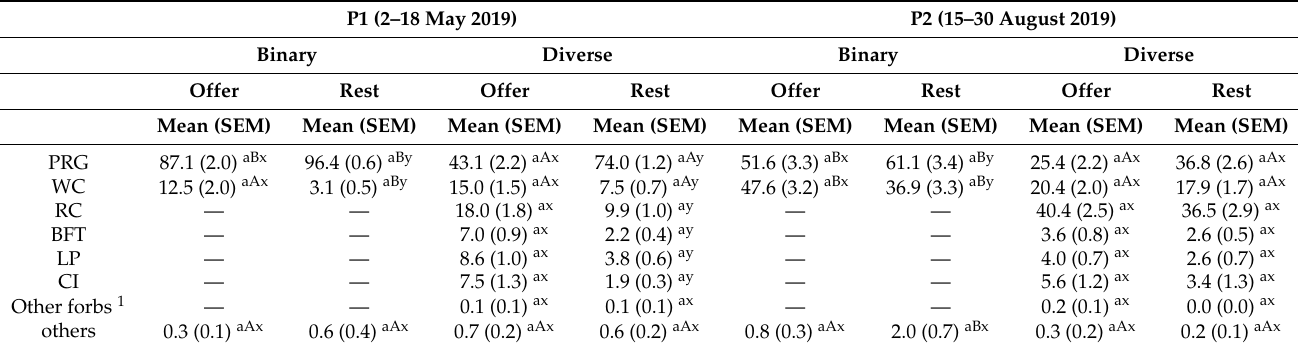
Table 4. Botanical composition (%) of the offered (Offer) and remaining (rest) herbage for the binary and diverse mixtures during both experimental periods. Abbreviations are as follows: PRG: perennial ryegrass, WC: white clover, RC: red clover, and BFT: birdsfoot